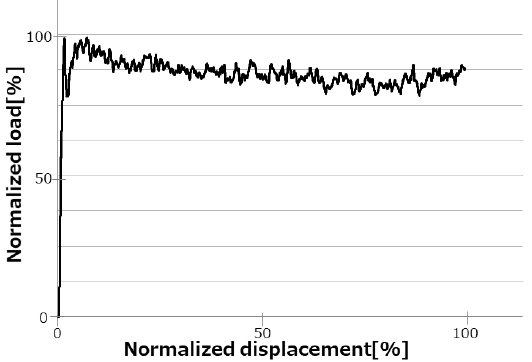
Figure 2. Load – displacement curve of FRP structure (typical).